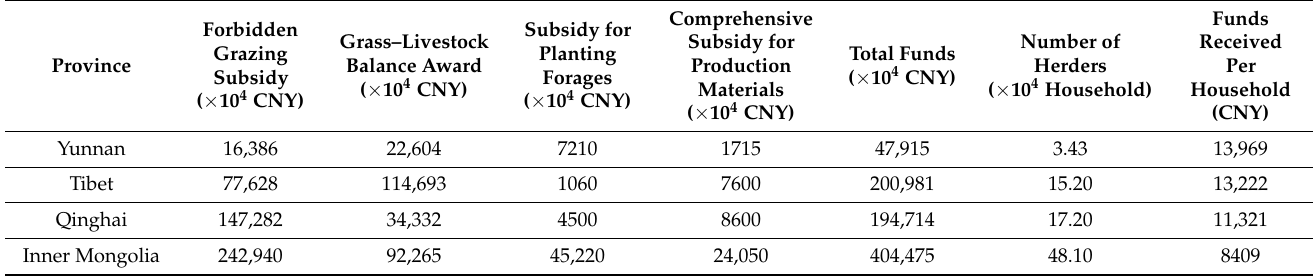
Table 2. GECSRP funding arrangements and amount received per household in